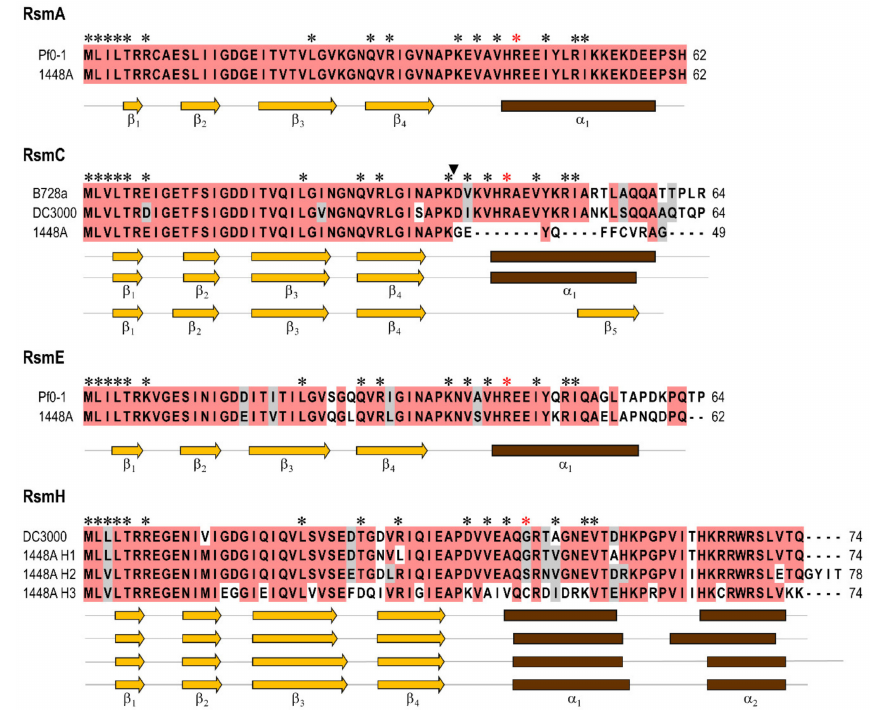
Figure 1. Sequence and structural conservation of the deduced products of the rsm homologues from P. amygdali pv. phaseolicola 1448A. All proteins were aligned using ClustalW, and identical or